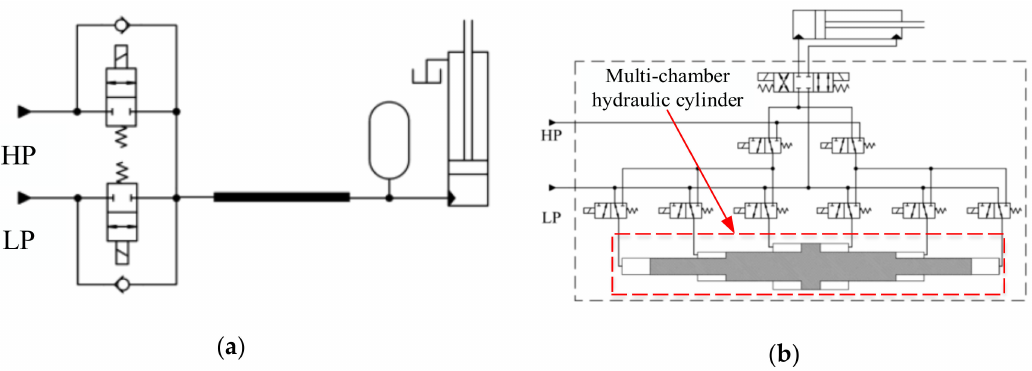
Figure 12. Digital hydraulic transformers: ( a ) high-speed switching digital hydraulic transformer; ( b ) parallel linear digital hydraulic transformer.